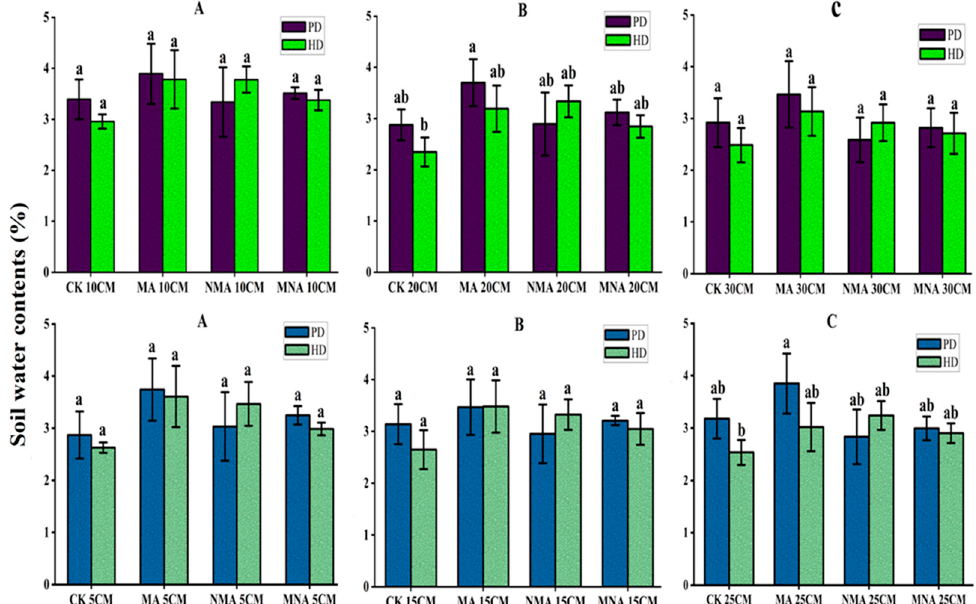
Figure 5. Soil water content in different treatments, depths ( A – C top row ), and distance away from the bamboo trunk ( A – C , bottom row ) in PD and HD directions. The bars are the standard error of the replications while the different letters on the bars indicate significant differences at p < 0.05.